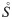
Reevaluation of published results.In 2010, Albrecht et al. compared var repertoires from 5 populations using pairwise type sharing (see Refs. [18, 19, 27] for original data details). (left) Reproduction of S˚ analysis of [19], rescaled from [0, 1]→[0, 60]. (middle) Reanalysis using Bayesian repertoire overlap [Eq (7)]. For all boxplots, boxes span inner quartiles; center lines show medians; whiskers extend to 2.5 and 97.5 percentiles. (right) Histograms of Bayesian repertoire overlap distributions from Amele and Ariquemes clones (data identical to those in middle boxplots) colored by width of credible interval [Eq (8)], a measure of uncertainty. Differences in uncertainties are driven primarily by sampling rates: Amele samples average n¯=15.6 sequences per parasite while Ariquemes clones average n¯=26.5.